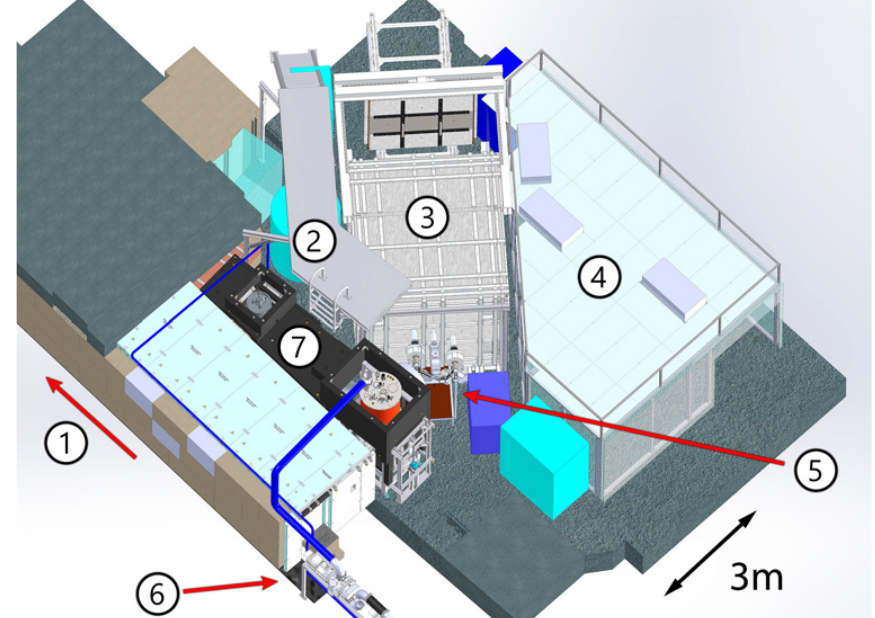
Figure 2. SuperSUN/PanEDM experimental area. 1: Towards reactor, 2: service platform above magnetic shields, 3: outer magnetic shield (MSR; detail in Fig. 4), 4: cleanroom, containing Cs and Hg magnetometer control, 5: HV apparatus and UCN optics (detail in Fig. 3), 6: SuperSUN 3 He pump system, 7: SuperSUN.